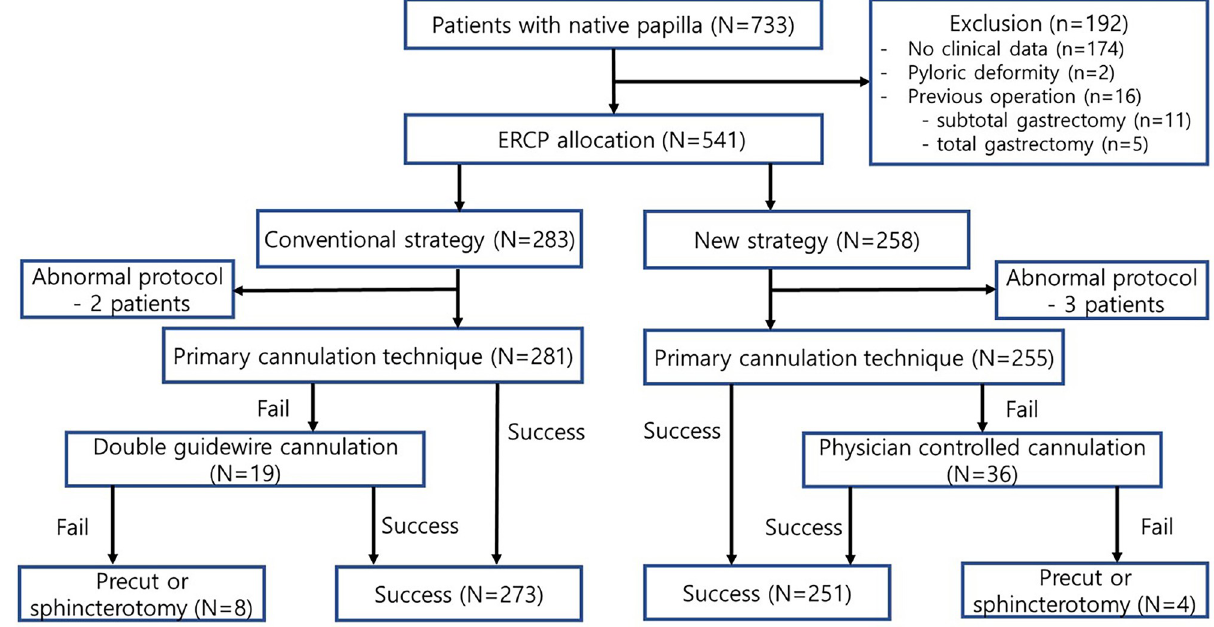
Fig 1. Flowchart of endoscopic retrograde cholangiopancreatography cannulation strategy with clinical results. ERCP, endoscopic retrograde cholangiography and pancreatography.